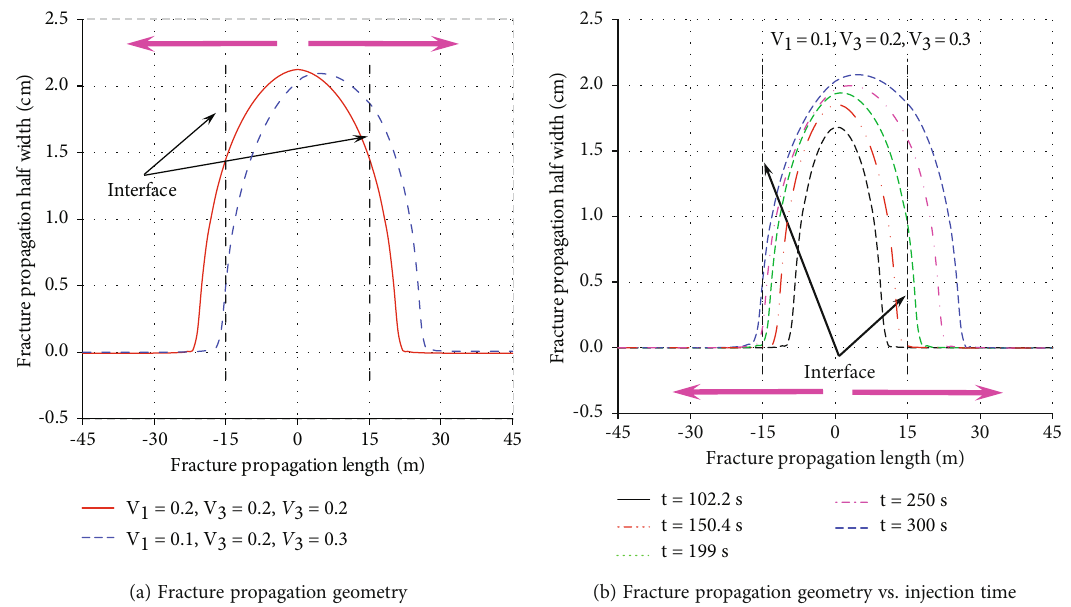
Figure 12: Hydraulic fracture propagates in lower-medium-higher Poisson ’ s ratio layer specimen.